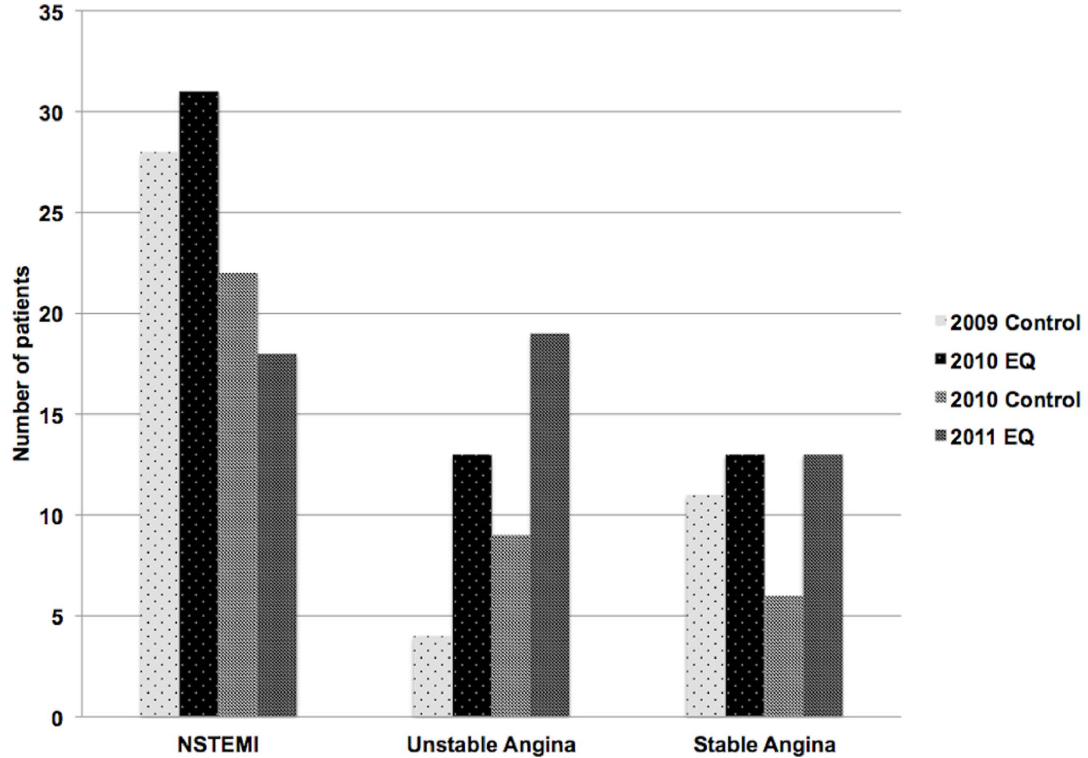
Figure 4. Other chest pain presentations in the first 2 weeks following both earthquakes.